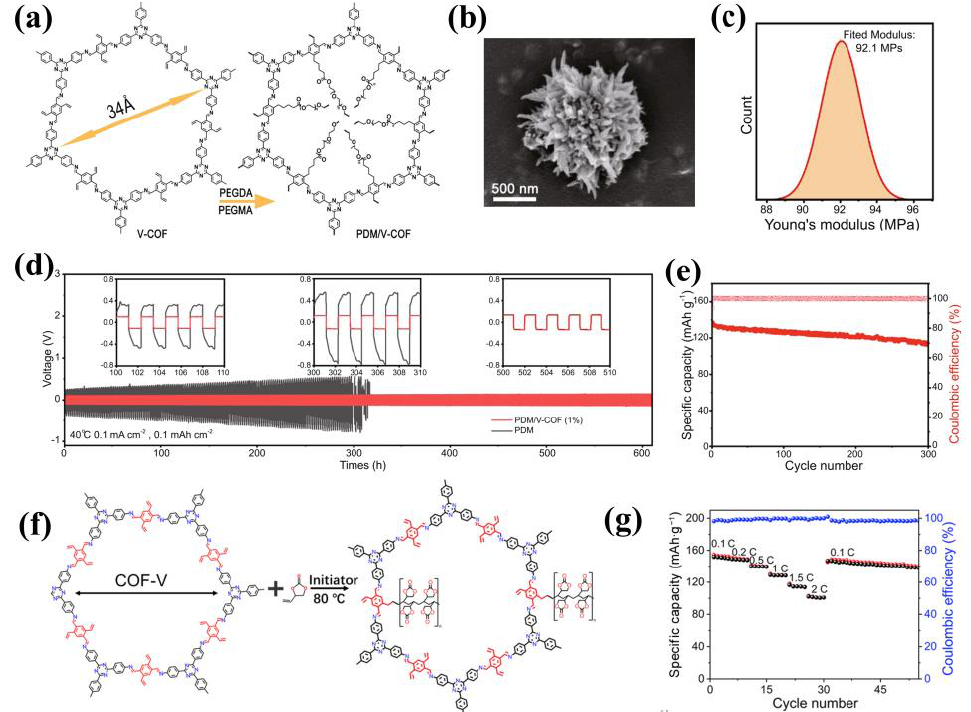
Figure 16. ( a ) Structure of V − COF and PDM/V − COF; ( b ) SEM image of V − COF; ( c ) Young ’ s modulus of PDM/V − COF (1%) after Gaussian fitting; ( d ) Long − term cycling of symmetrical lithium metal cells using PDM/V − COF (1%) (red) and PDM electrolyte (black) at 40 °C; ( e ) The long − time cycling performance of Li|PDM/V − COF (1%)|LiFePO 4 cells at 1 C [80]. Ref. [80] is an open − access article distributed under the terms of the Creative Commons CC BY li − cense, which permits unrestricted use, distribution, and reproduction in any medium provided the original work is properly cited; ( f ) Structure of COF − PVEC composite electrolyte; ( g ) Rate performance of LFP/COF − PVEC/Li cells at varied current densities. Reproduced with permission from Ref. [81], Copyright (2022), Springer Nature.